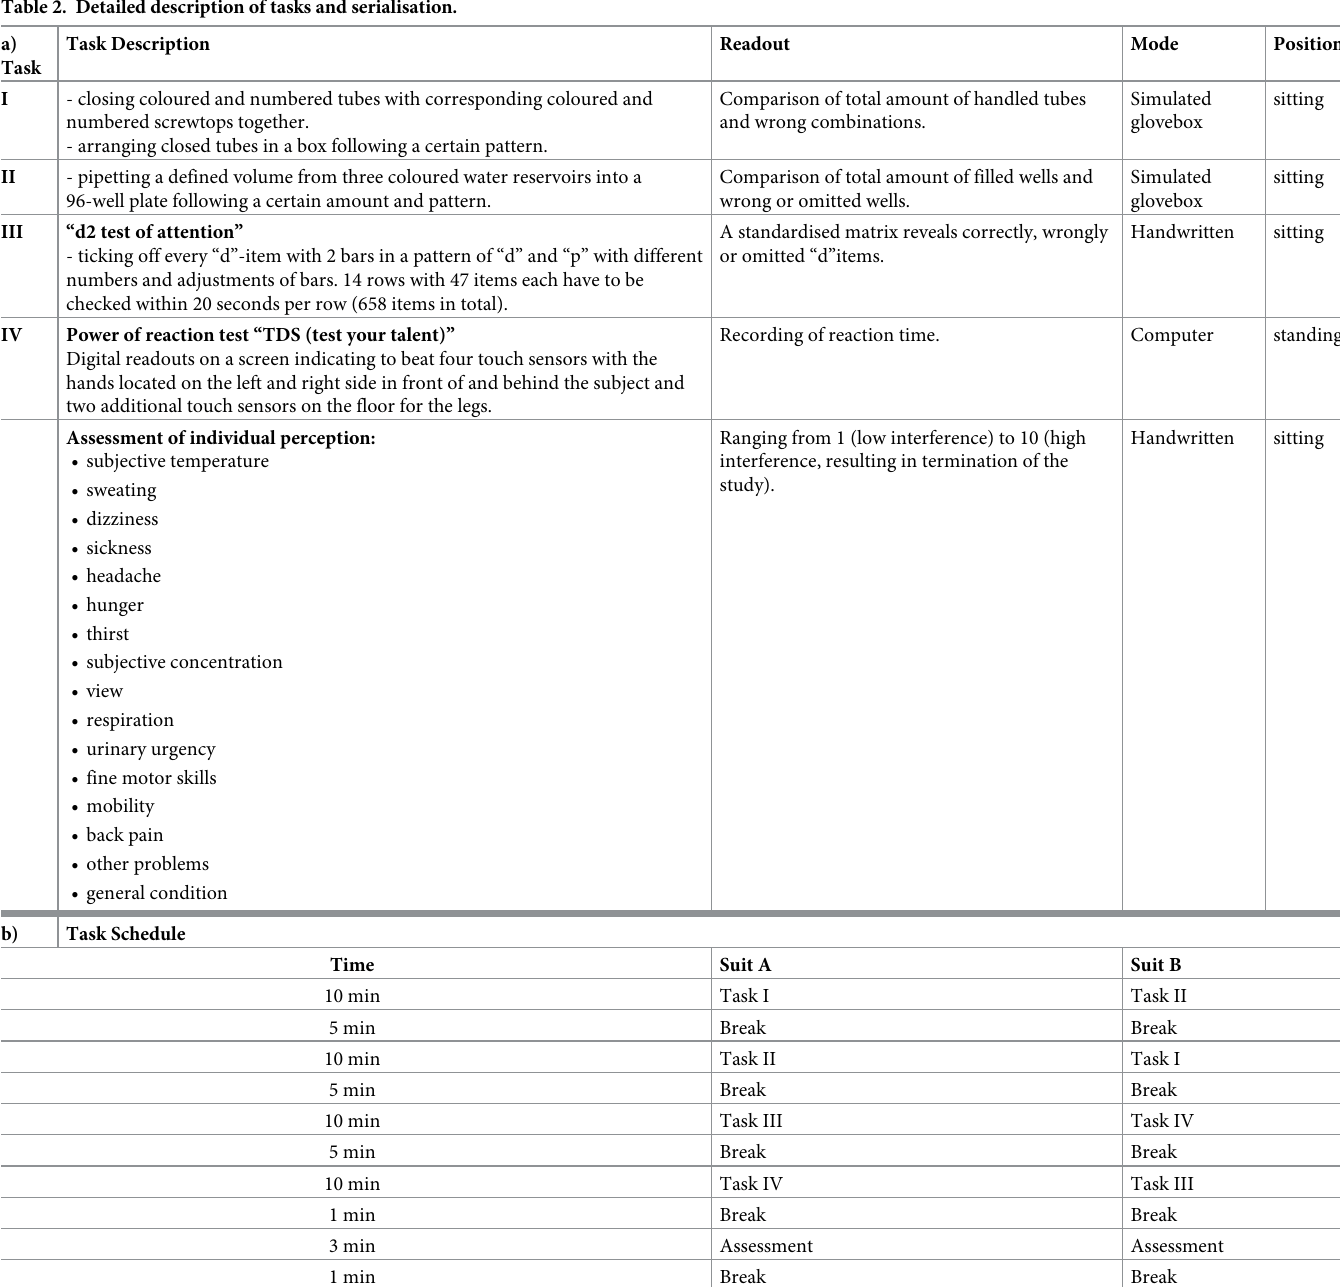
All subjects wearing their randomly allocated suits participated in task series at 22˚ and 28˚C. Physical measurements: Heart rate, fluid loss and body temperature. Measurement of error rates in task I. Measurement of concentration (d2 Test, task III). Measurement of reaction time (task IV).